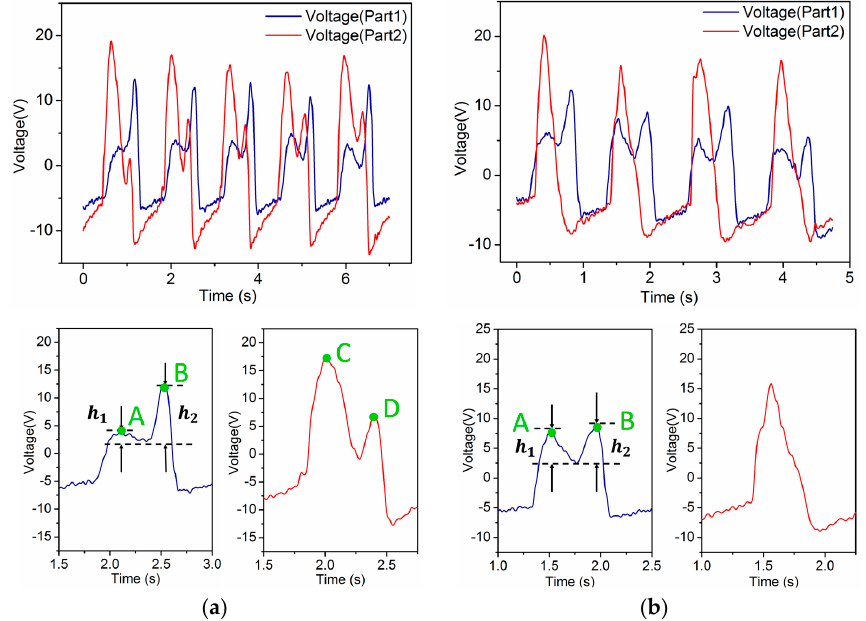
Figure 6. Waveforms and characteristics of voltage output from the self-powered insole. ( a ) Waveforms and characteristics of ascending stairs, double peaks in voltage of part1 and part2, and h 2 > h 1 . ( b ) Waveforms and characteristics of descending stairs, double peaks in voltage of part1, but not in part2.